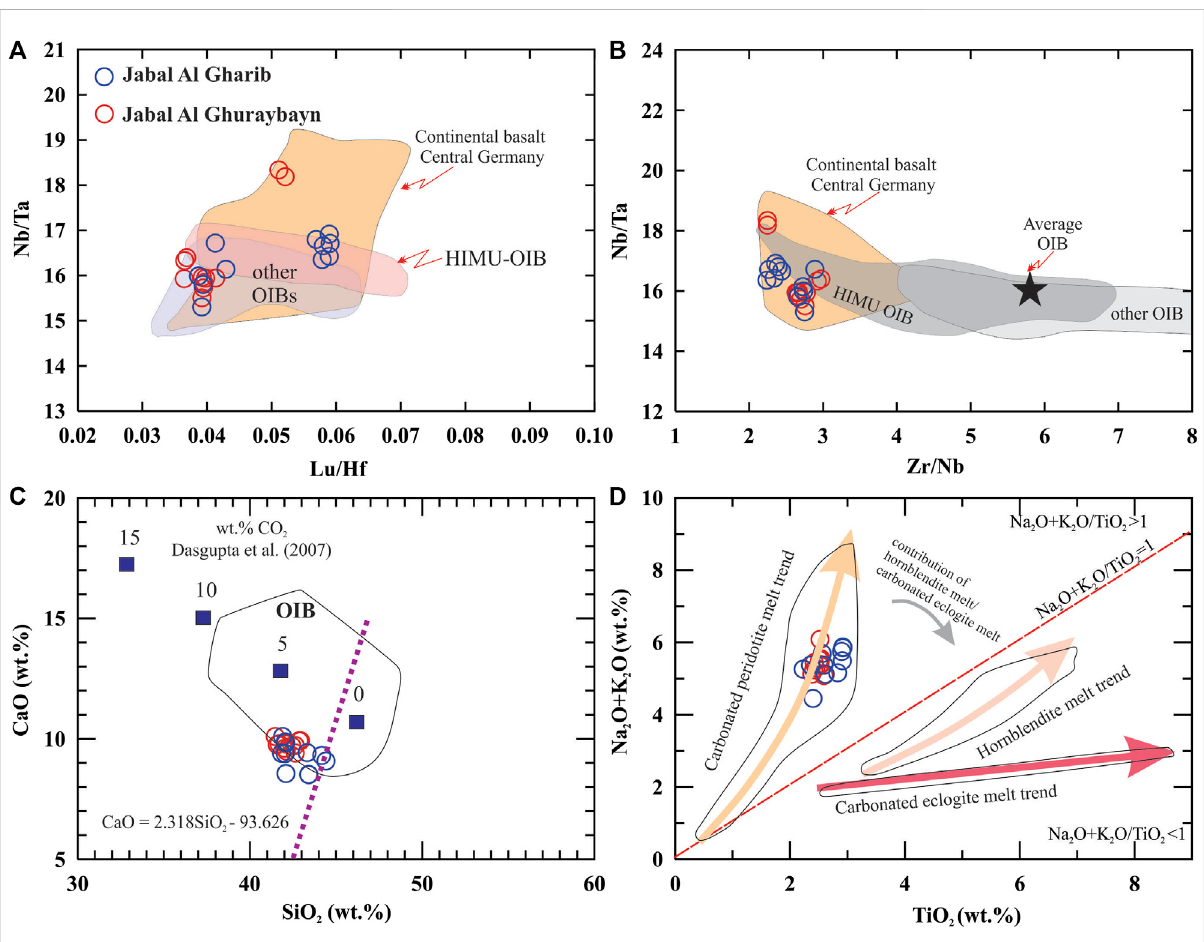
FIGURE 8 Plots of Nb/Ta vs. (A) Lu/Hf, and (B) Zr/Nb. Ocean-island basalts (OIBs) including HIMU (high μ refers to high 238U/204Pb ratios) basalts and average OIB are from Pfänder et al. (2007), whereas continental basalts from Central Germany are from Pfänder et al. (2012). (C) SiO 2 and CaO contents compared with partial melts of carbonated peridotite (Dasgupta et al., 2007). The dashed line is an approximate fi lter separating CO 2 - enriched and CO 2 -de fi cient lavas (after Herzberg and Asimow, 2008). OIB fi eld represents lavas from the Canary and Galápagos Islands (Herzberg and Asimow, 2008). (D) Variations in total alkalis vs. TiO 2 (Zeng et al., 2010). Experimental melts from carbonated peridotite (Dasgupta et al., 2007), carbonated eclogite (Dasgupta et al., 2006), and hornblendite (Pilet et al., 2008) are shown for